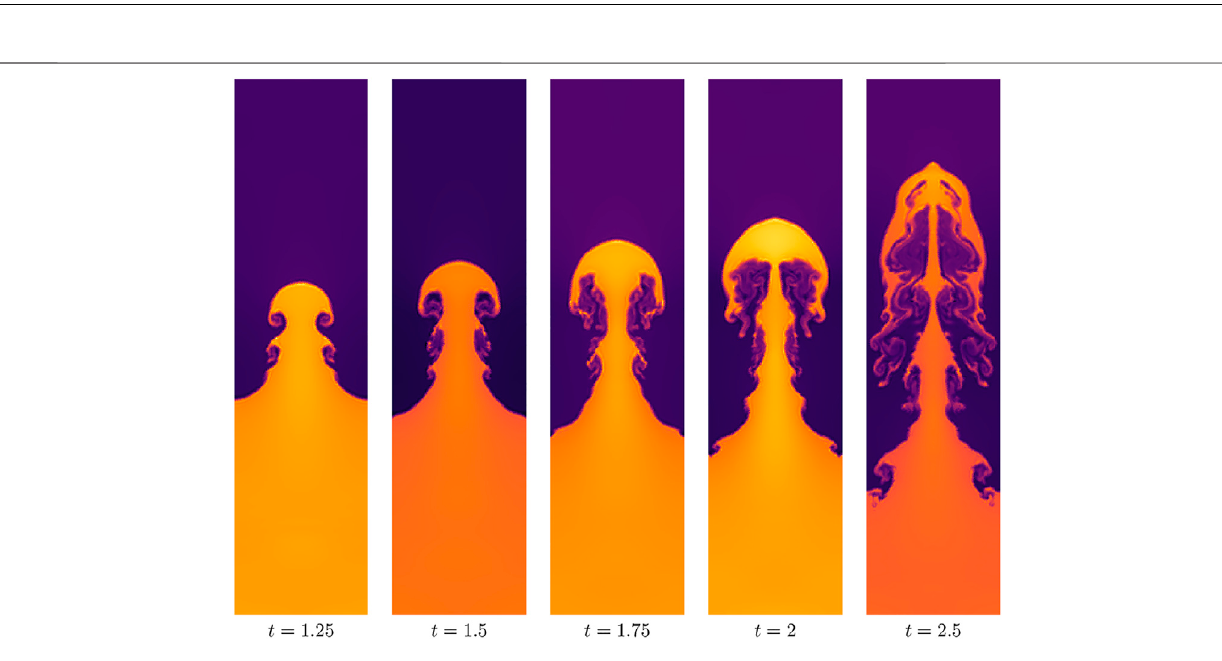
FIGURE 2 | Density for a Rayleigh-Taylor instability for a degree N = 3 entropy stable Gauss DG scheme on a mesh of 32 × 128 elements.